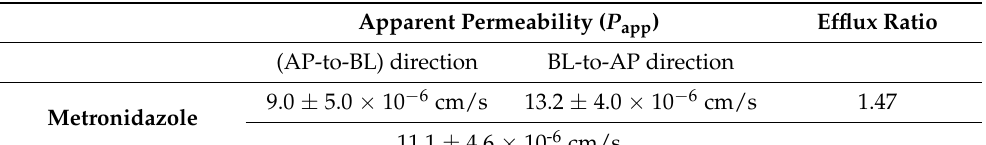
Table A1. P app of metronidazole (16 µ g/mL) in the AP-to-BL and BL-to-AP directions. Results are presented as mean values ± SD from 3 independent experiments.